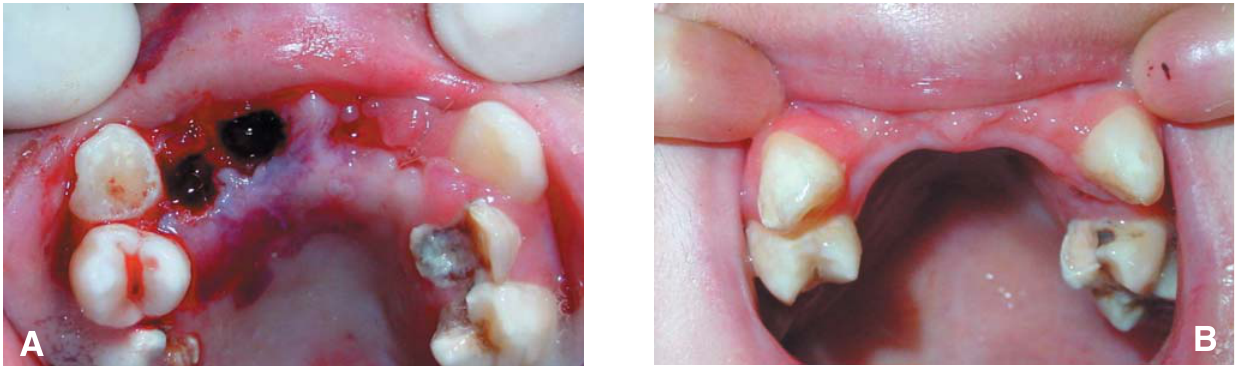
FIGURE 3- A= Immediate (maxillary right central and lateral incisors) and 7-day (maxillary left central and lateral incisors) postoperative aspect. Note the hemorrhagic blisters on the lip and palate after surgery. B= Oral aspect 1 month after the first surgical procedure